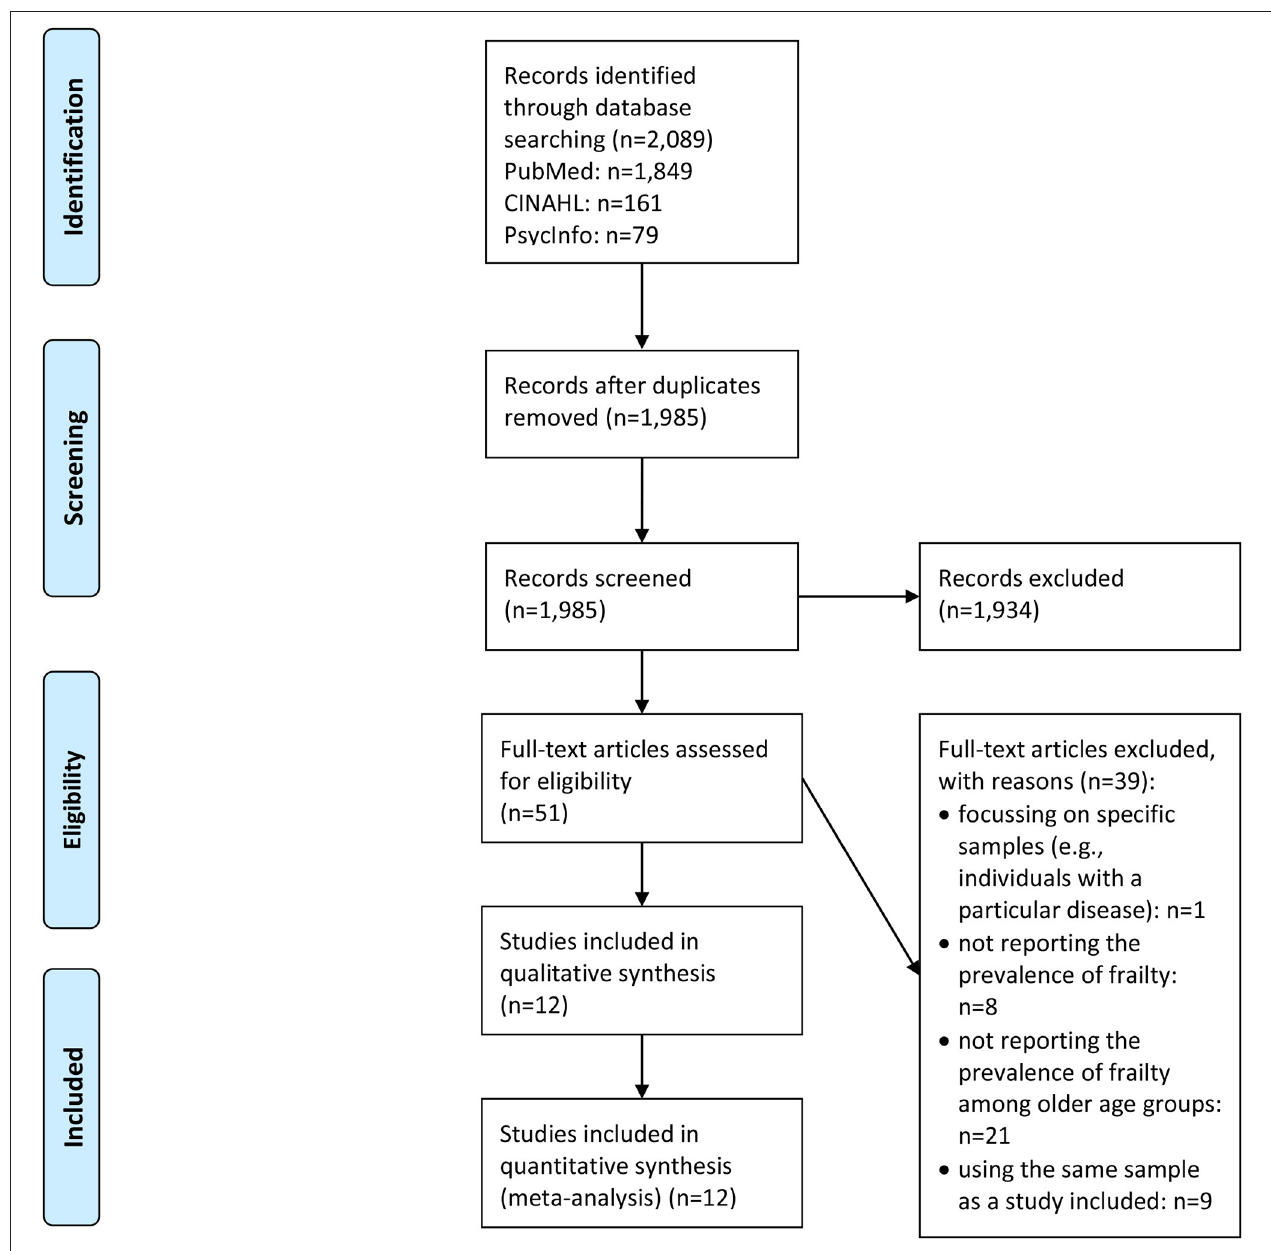
FIGURE 1 | PRISMA flow